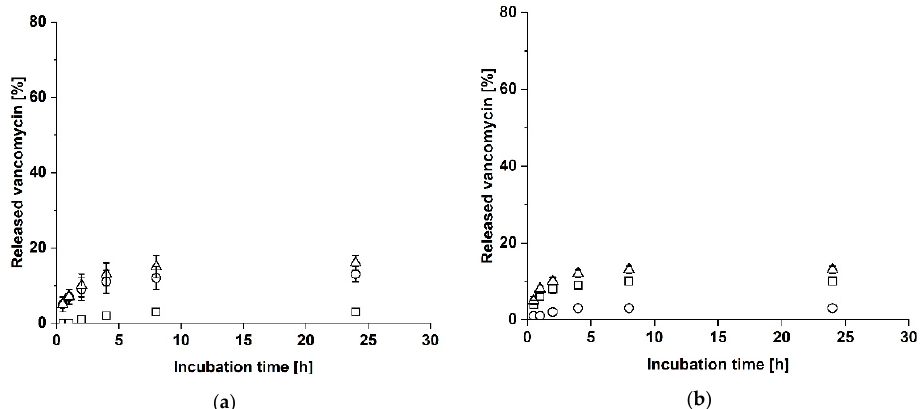
Figure 5. Release of vancomycin from a two-layer laminate consisting of Atelocollagen and Collagen Solutions. Collagen Solutions was loaded with vancomycin and the release in the upper cavity (squares), the lower cavity (dots) and in total (triangles) was analyzed. The error bars represent the standard deviation ( n = 3). ( a ) Collagen Solutions facing the lower cavity. ( b ) Collagen Solutions facing the upper cavity.